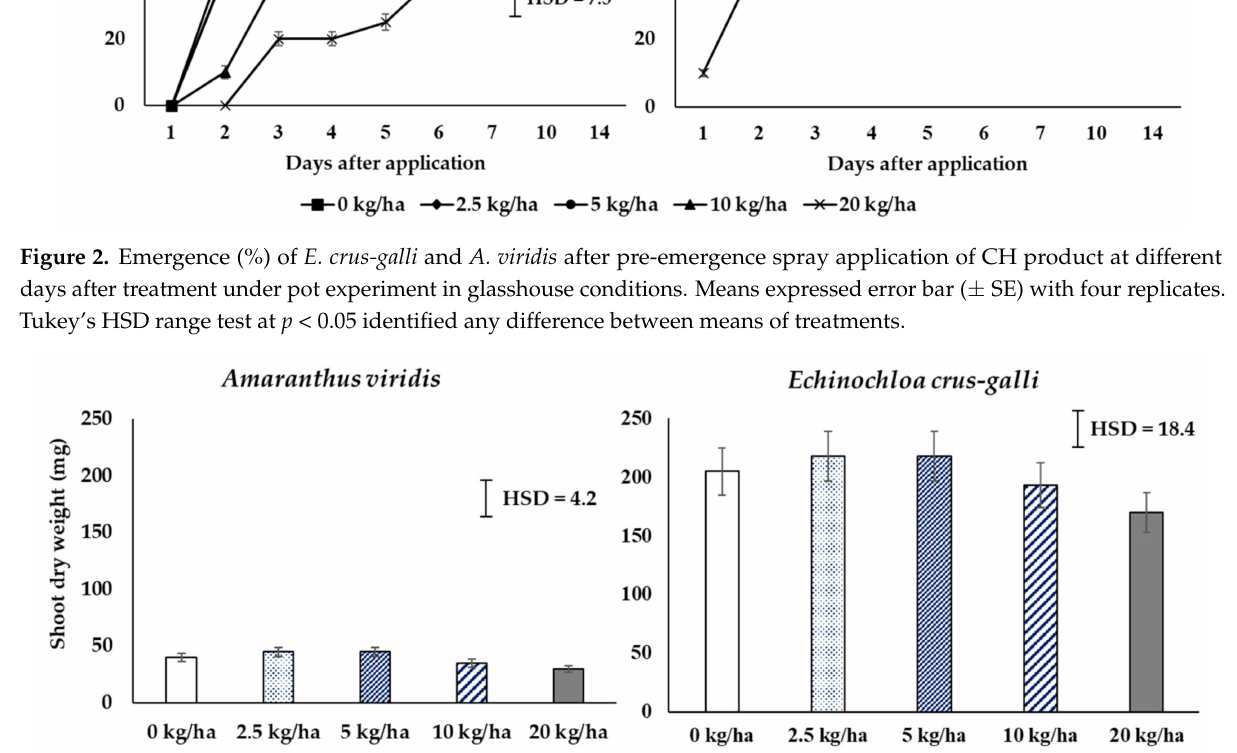
Figure 3. Shoot dry weight of surviving E. crus-galli and A. viridis seedlings at 21 days after pre-emergence spray application of CH product under pot experiment in glasshouse conditions. Means expressed error bar ( ± SE) with four replicates. Tukey’s HSD range test at p < 0.05 identified any difference between means of